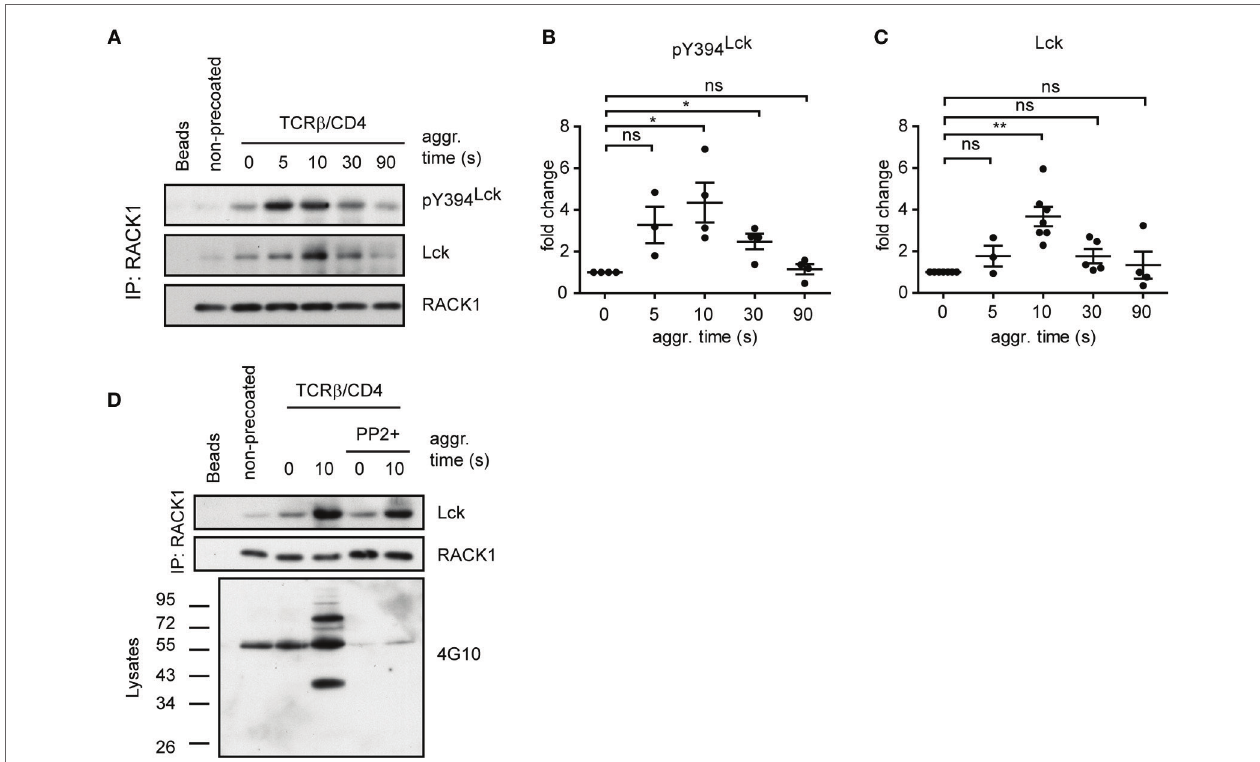
FigUre 5 | racK1–lck complexes can form irrespective of lck kinase activity, but those from activated T-cells contain a sizeable fraction of pY394 lck . (a) CD4 + T-cells precoated or non-precoated with biotinylated anti-TCR and anti-CD4 mAbs (TCR β /CD4) were co-aggregated, or not (0 s), with streptavidin for the indicated period of time. RACK1 immunoprecipitates were blotted against pY394 Lck , total Lck, and RACK1. (B,c) Statistical analysis of pY394Lck and total Lck blots from (a) , respectively, represent the normalized to total RACK1 from at least three independent experiments. The statistical analysis presented as mean ± SD was performed using the Student’s two-tailed t -test, * p < 0.05, ** p < 0.01, n.s., not significant. (D) CD4 + T-cells were pretreated, or untreated, with SFK inhibitor (PP2 + ), TCR β /CD4 co-aggregated, and lysed in TNE lysis buffer. RACK1 was immunoprecipitated and aliquots blotted against total Lck and RACK1; total cell lysates were blotted with anti-pY 4G10 antibody. Blots shown in (a,D) are representative of at least three independent